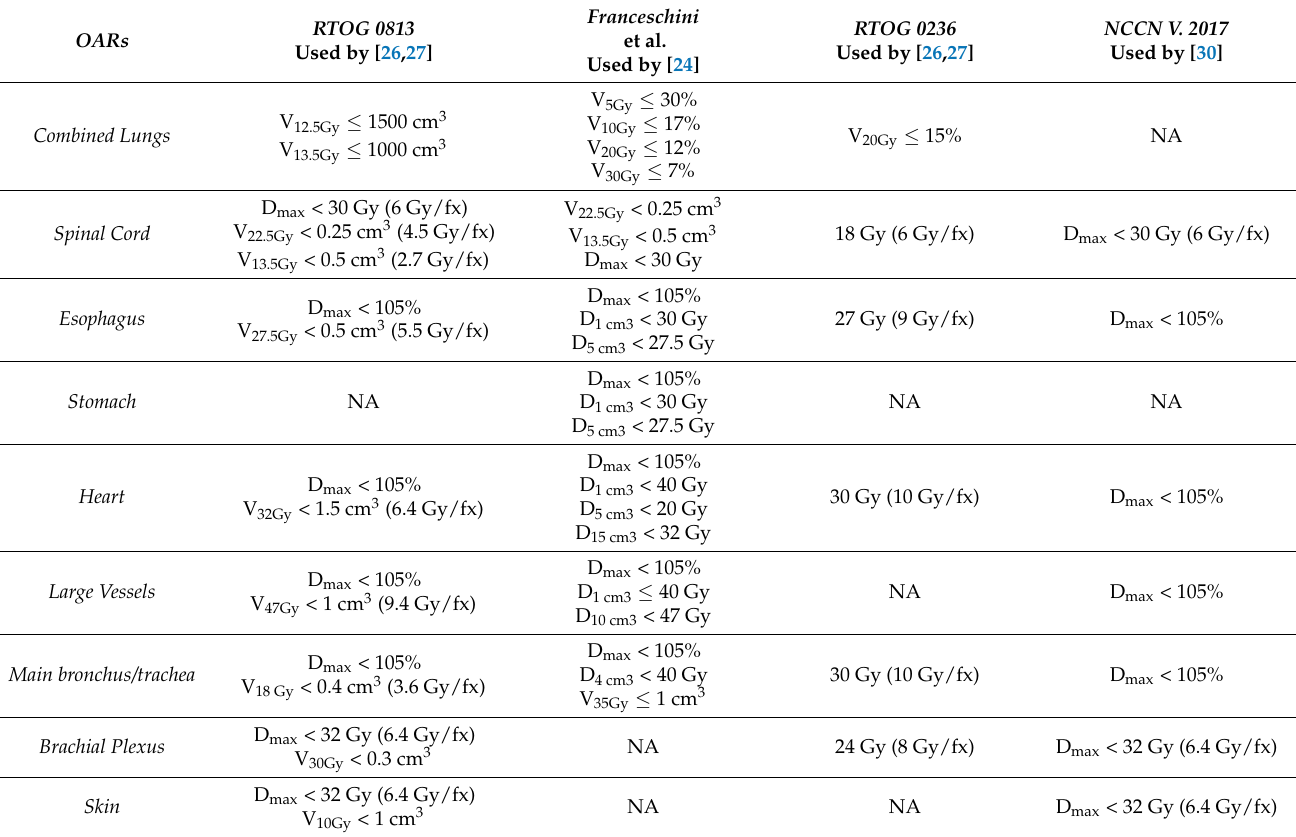
Table 3. Summary of the constraints used in the articles. For simplicity, only the constraints in 5 fractions have been